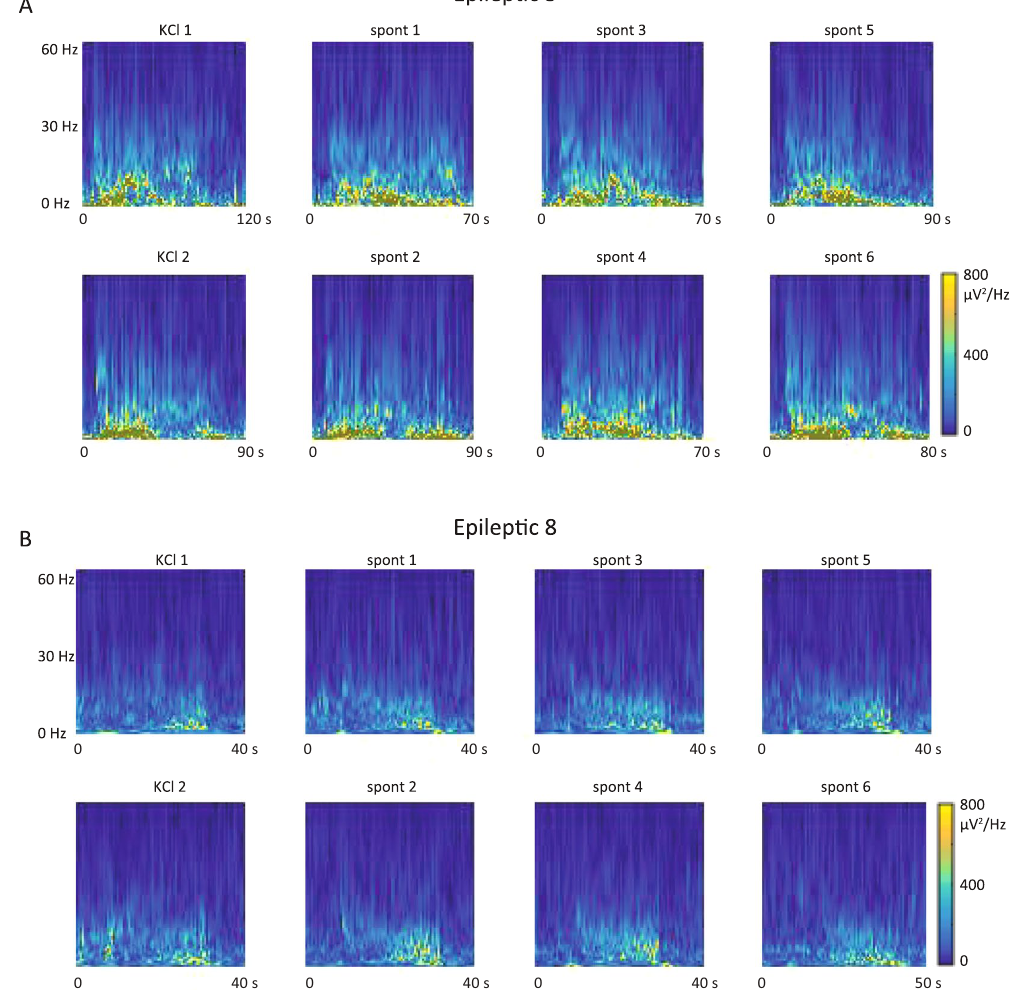
Figure 3. Seizures occurring during the KCl injections versus spontaneous seizures, frequency data. Seizures from Epileptic 3 ( A ) and Epileptic 8 ( B ) were converted into Morlet plots, which show the change in spectral power over time. The plots show data from each seizure. In each animal, there are two seizures occurring during the KCl injections and six spontaneous seizures shown; the first two columns correspond to the raw data in Fig. 2. Each rat has a distinct spectral pattern during their seizures, with some variability between different events. It is clear that the seizures occurring during the KCl injections in each rat are similar to their own spontaneous seizures, but different from the other animal’s seizures. X-axes show duration of each seizure, also including 10 s of EEG before and after the seizure. All plots have the same y-axis (0 to 60 Hz) and color scale. Additional data from these and all other Epileptic animals are included in the